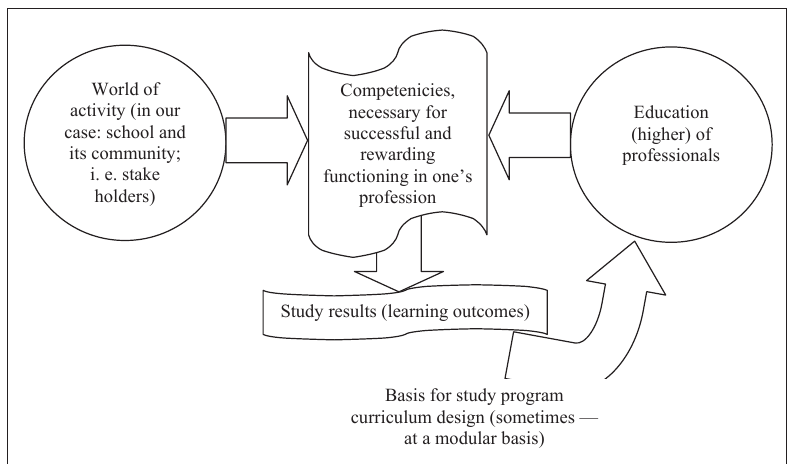
Fig. Competencies as basis for education of